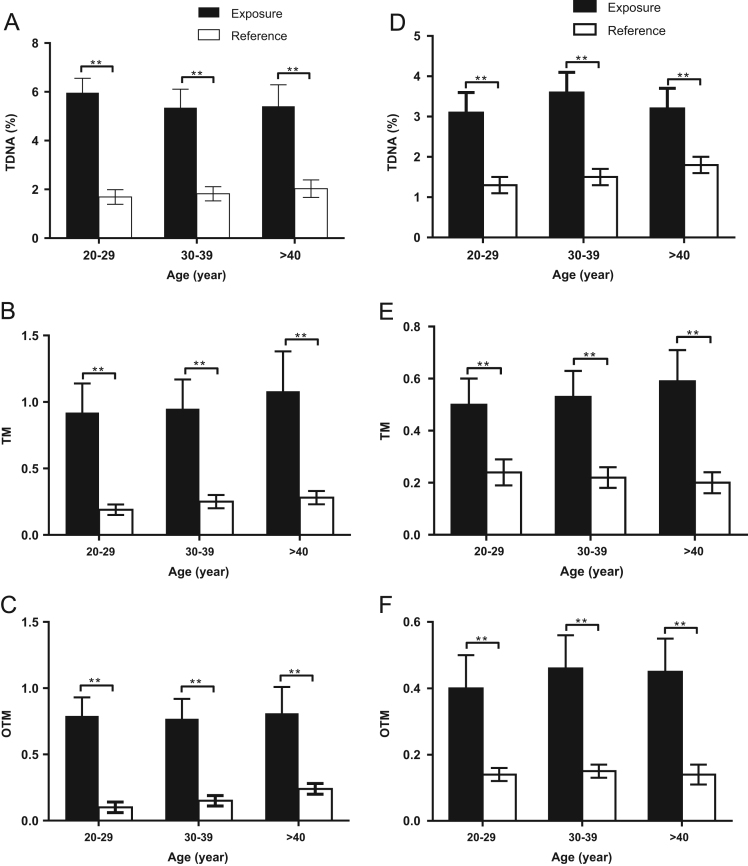
DNA damage detected by comet assay in lymphocytes and spermatozoa for different age sub-groups. The group of workers recycling e-wastes and reference group were both divided into three sub-groups by age (20–29, 30–39 and >40 years old). A-C: TDNA%, TM and OTM in lymphocytes between the group of workers recycling e-wastes and reference group for the sub-groups divided by age. D-F: TDNA%, TM and OTM in spermatozoa between the group of workers recycling e-wastes and reference group for the sub-groups divided by age. **: P < 0.01. Two way ANOVA was also used to test the interactions between age and DNA damage in lymphocytes and spermatozoa, respectively. (lymphocytes: F = 2.13, P = 0.15; spermatozoa: F = 1.67, P = 0.21).